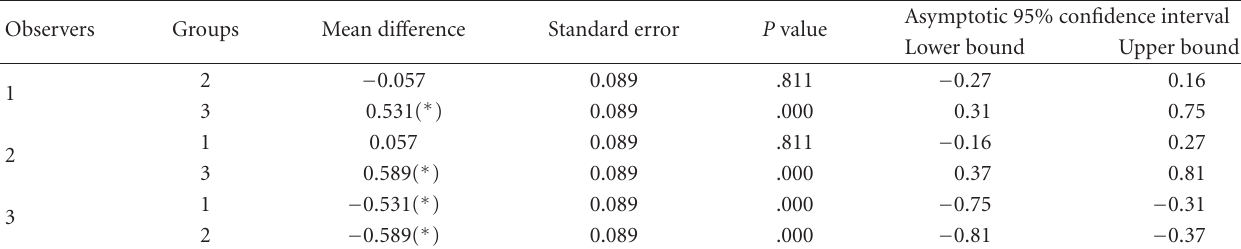
Table 3: Results of Sche ff e test.